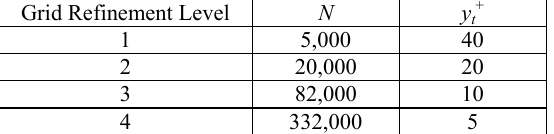
Figure 11. Normalized streamwise velocity profiles at x/h = - 5.8, x/h = 2.6 , x/h = 6 , x/h = 13.5, x/h = 20 and x/h =